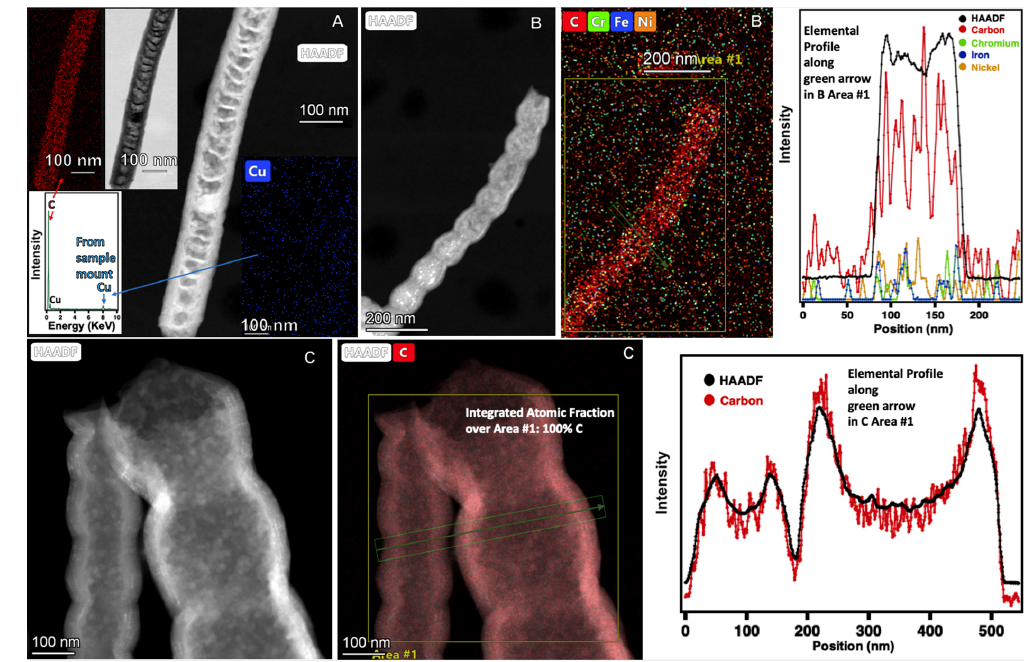
Figure 4. High angle annular dark-field TEM (HAADF) elemental analysis of nano-bamboo (panel A) and nano-pearl (panels B and C and HAADF elemental profiles) carbon allotropes synthesized by molten carbonate electrolysis. ( A ): Nano-bamboo with elemental analysis; ( B ): Nano-pearl with Elemental profile; ( C ): Nanopearl with Elemental profile.